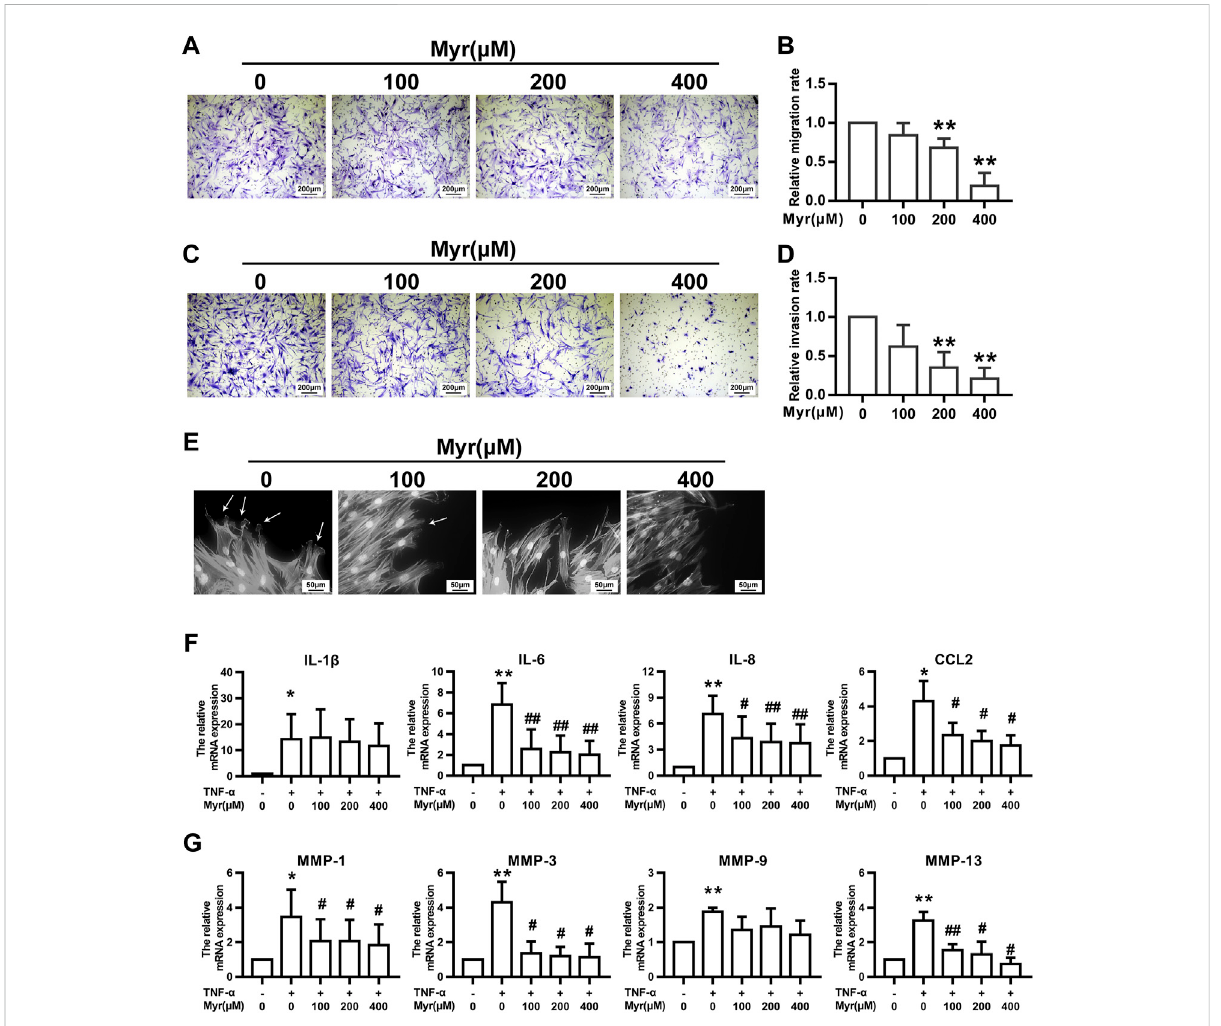
FIGURE 2 Myr inhibits the migration, invasion, and TNF- α – induced expression of proin fl ammatory cytokines and MMPs of RA FLSs. The cells were pretreated with DMSO or Myr (100, 200, and 400 μ M) for 24 h (A – D) The migration and invasion of RA FLSs were evaluated by a Boyden chamber assay. Transwell inserts coated with a Matrigel basement membrane matrix were used to detect the invasion of RA FLSs. The relative migration or invasionratewascalculatedbycountingmigratedorinvadedcellsandthennormalizedtothatinDMSOgroup. Representativeimages (original magni fi cation, ×100) are shown. Graphs show the relative migration (B) and invasion (D) rates. (E) Myr impaired lamellipodia formation of RA FLSs. Arrows indicate lamellipodia formation. Representative images are shown (original magni fi cation, ×400). (F,G) The cells were preincubated with DMSO, DMSO with TNF- α (10 ng/ml) or Myr (100, 200, and 400 μ M) with TNF- α for 24 h. RT-qPCR was used to measure the expression of proin fl ammatory cytokines (F) and MMPs (G) in RA FLSs. Data (B,D,F,G) show the mean ± SD of samples from at least 3 independent